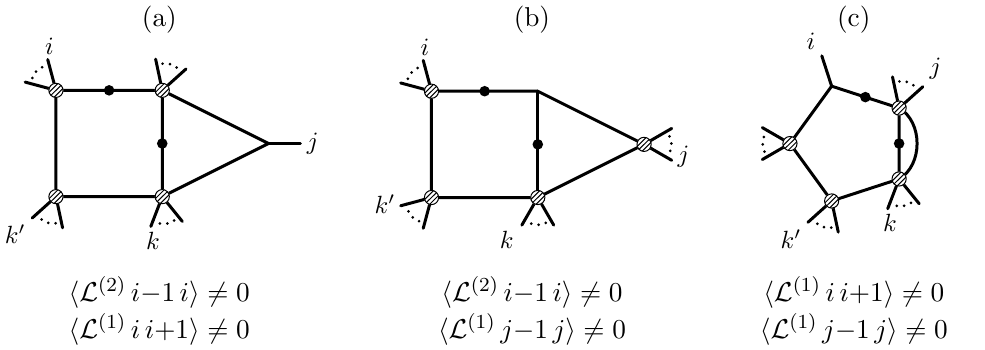
Figure 4 . These are the unique minimally NMHV relaxations of the diagrams (cid:12)gure 3. As such, these are also double-relaxations of table 2(a). Computing the associated singularities is discussed in the text. Any further relaxations of triangles yield bubble subdiagrams. In (c), relaxing either (2) i i of 1 = 0 yields the four-mass bubble-box of (cid:12)gure hL (cid:6) i